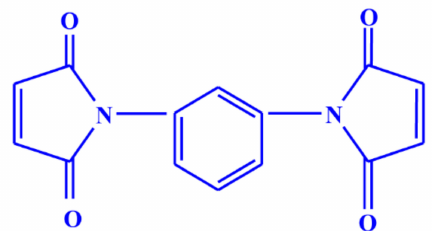
Figure 1. Chemical structure of N, N’-meta phenylene dimaleimide (Maleide F).